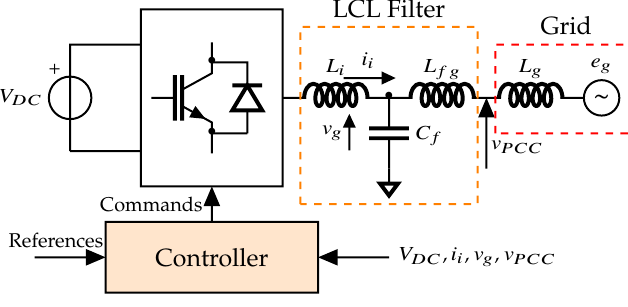
Figure 3. Diagram of the system to be modeled.